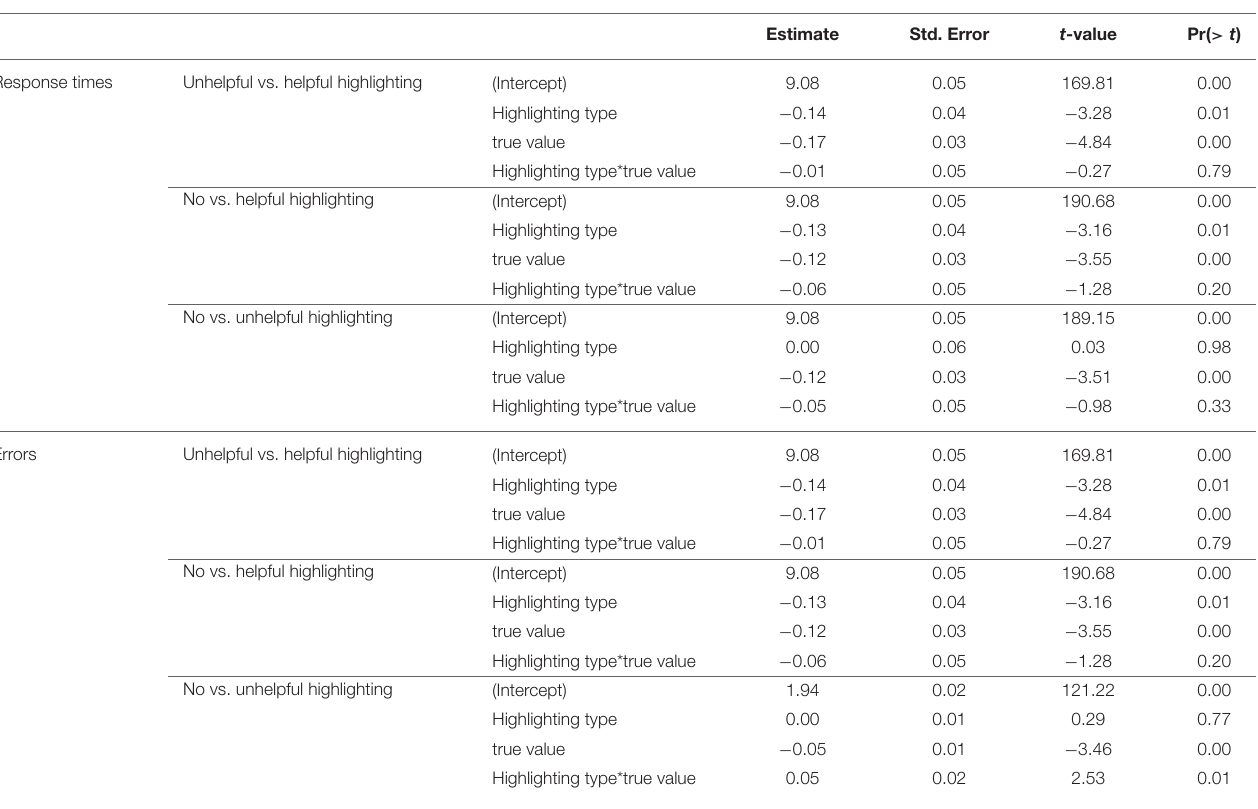
TABLE 4 | Experiment 3, models for response times in log(ms) comparing highlighting